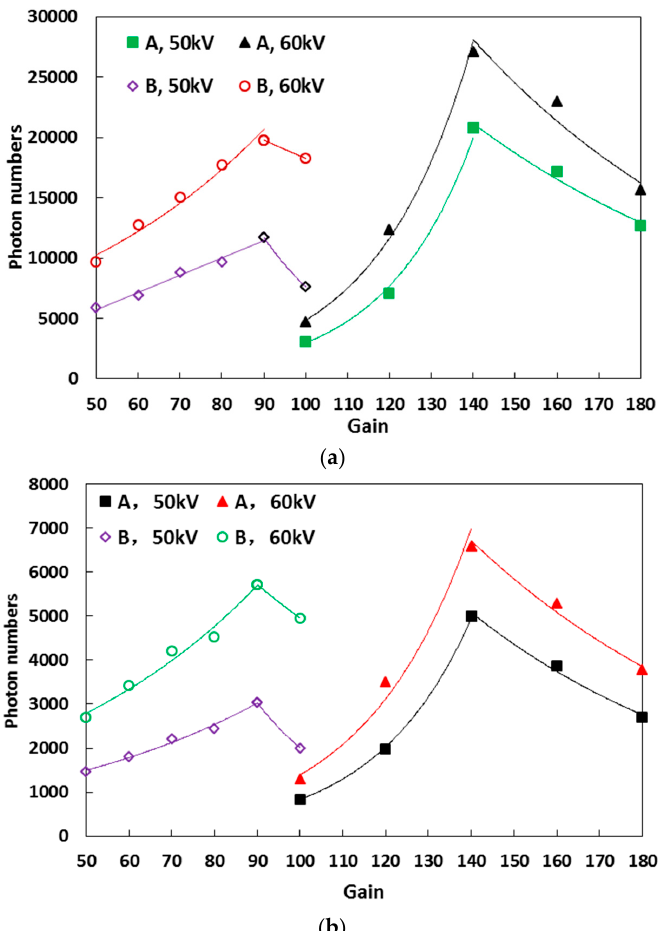
Figure 8. Influence of imager gains on corona discharge photon numbers for sample I ( p = 98.09 kPa; T = 20 °C; RH = 78.2%). ( a ) d = 6 m; ( b ) d = 12 m.